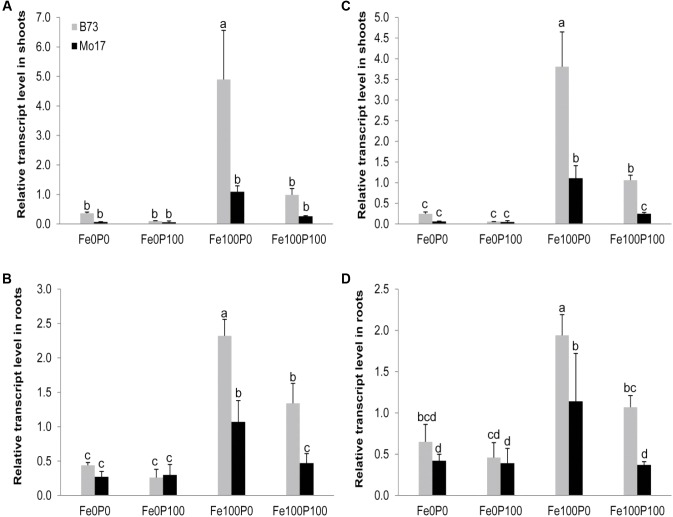
Influence of varied Fe and P nutritional regimes on ferritin gene expression. Relative transcript levels of ZmFer1
(A,B) and ZmFer2
(C,D) in shoots (A,C) and roots (B,D) of B73 and Mo17 plants grown for 15 days in nutrient solution supplemented without Fe and P (Fe0P0), without Fe and with 100 μM P (Fe0P100), with 100 μM Fe and without P (Fe100P0) or with 100 μM Fe and 100 μM P (Fe100P100). Fe and P treatments were initiated after one week of preculture on full nutrient solution. The housekeeping gene ZmGAPDH was used for normalization of mRNA levels, which were set to 1.0 in B73 grown at Fe100P100. Bars indicate mean values ± SD, n = 4. Different letters denote significant differences at p < 0.05.